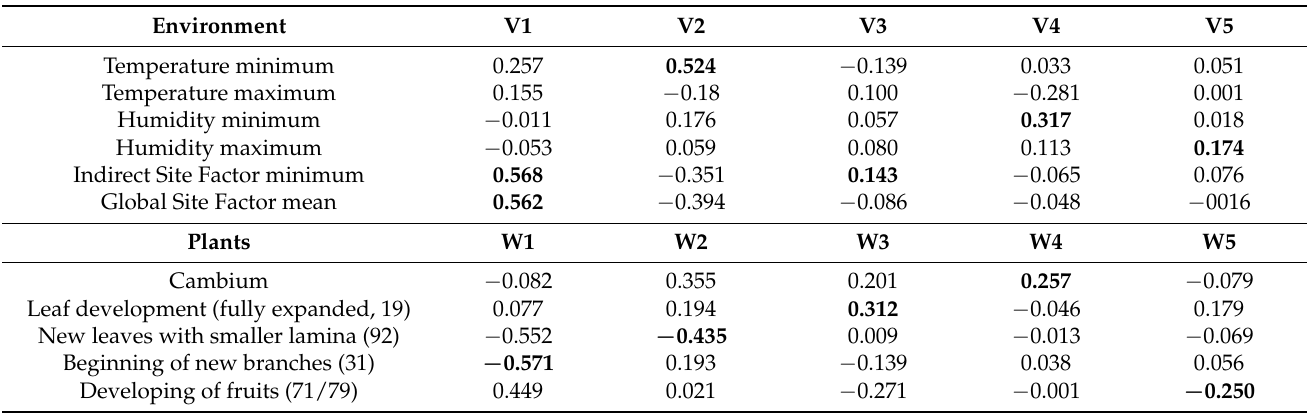
Table 5. Canonical cross-loadings of the first five pairs of canonical variables of environment with cambium and phenology of Acaena elongata . Bold indicates the environmental or plant variables with the highest